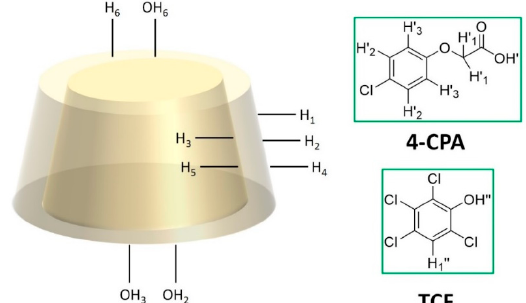
Figure 1. Proton assignment for β -cyclodextrin ( β -CD) and both pesticides (4-chlorophenoxyacetic acid (4-CPA) and 2,3,4,6-tetrachlorophenol (TCF)).